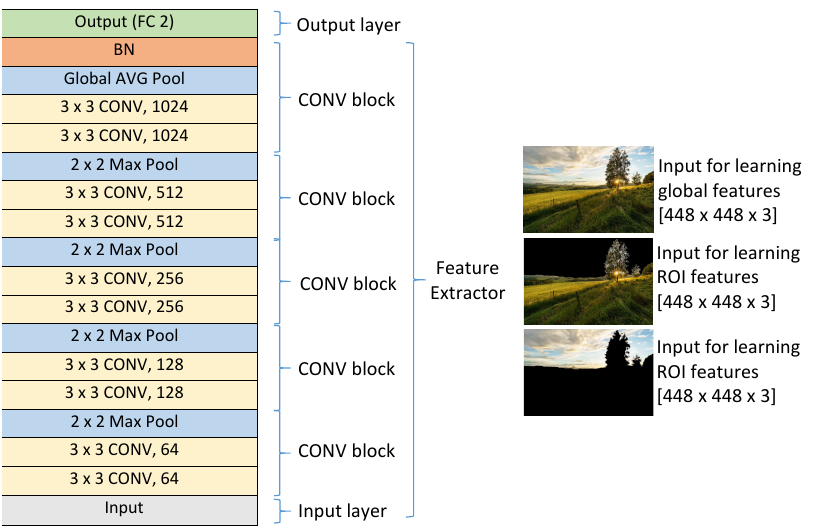
Figure 14. General structure of the models learning aesthetic features from the whole image, ROIs and background.